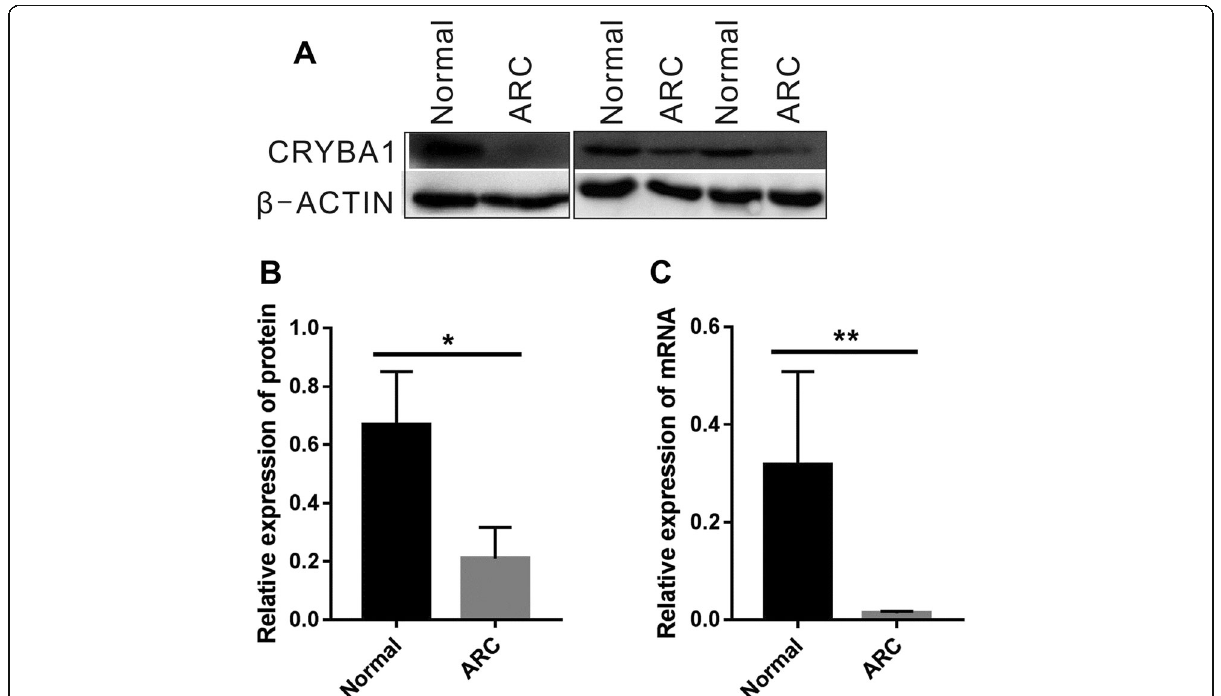
Fig. 3 CRYBA1 is expressed less in cataract lens epithelium. ( a ) Western blot images of CRYBA1 in ARC and normal control lens epithelium. Three samples from each group are presented. β -Actin was used as an internal control. ( b ) Quantification of the gel images of the Western blots in ( a ) ( n = 3). ( c ) The mRNA level of CRYBA1 was measured by qPCR in ARC and normal control lens epithelium. β -Actin was used as an internal control (n = 3). Student ’ s t test, * P < 0.05, ** P <